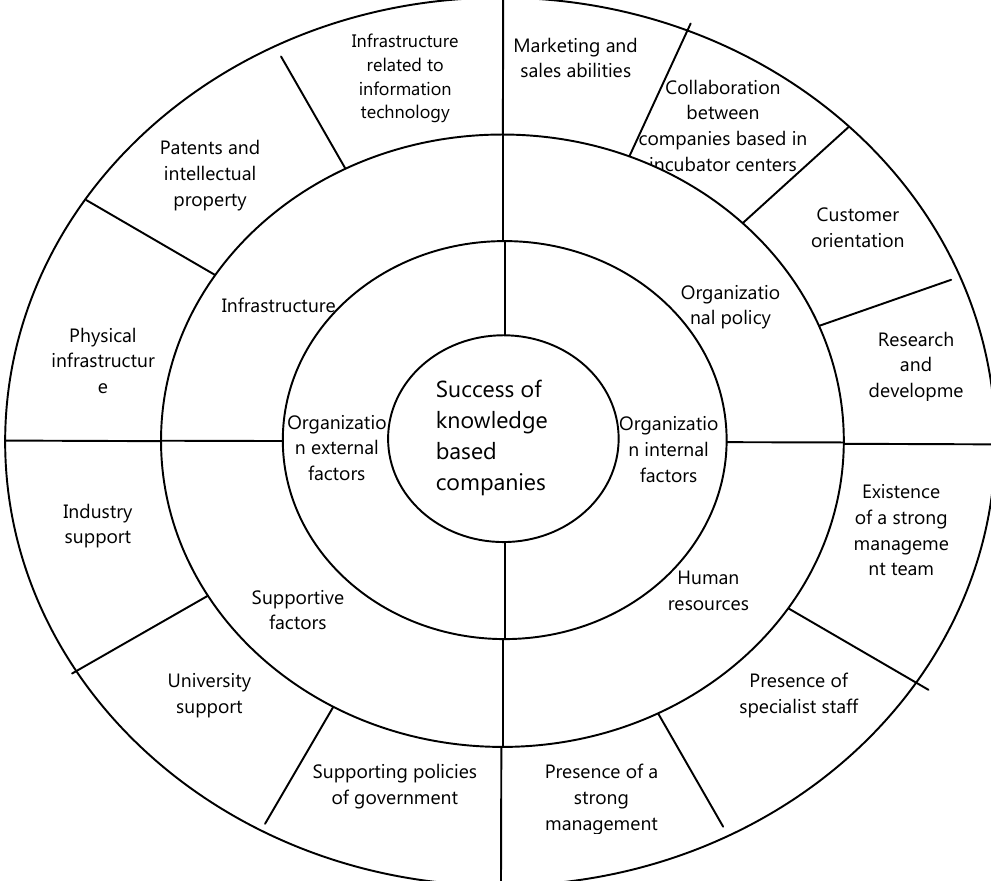
Fig. 3: The Inference Model of Qualitative